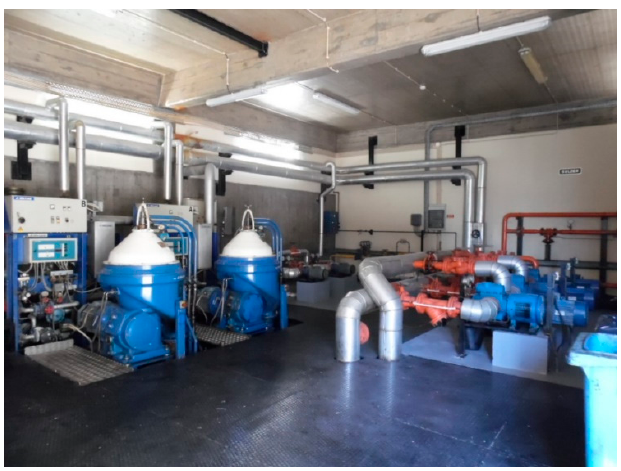
Figure 5. Fuel oil treatment including centrifugal separators and fuel pumps.